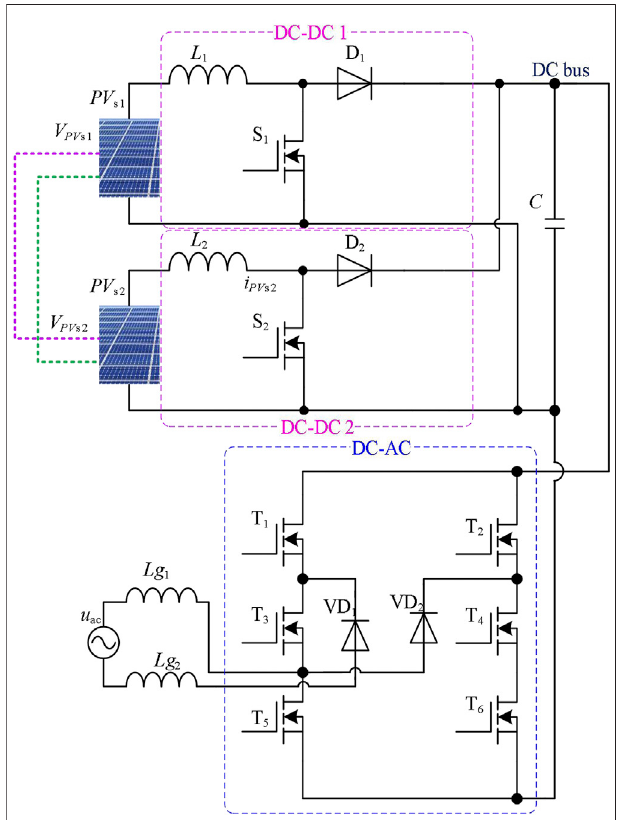
FIGURE 10 | Main circuit topology structure of the experimental platform.